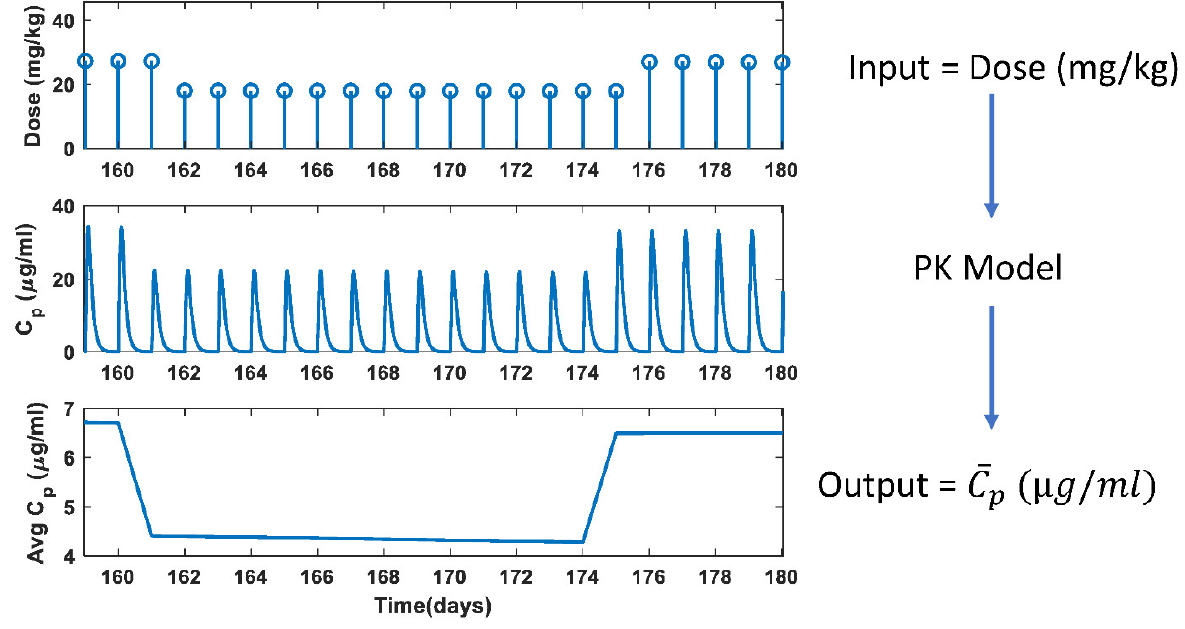
Figure 10. Pharmacokinetic model simulations performed every day for a representative partici- pant.